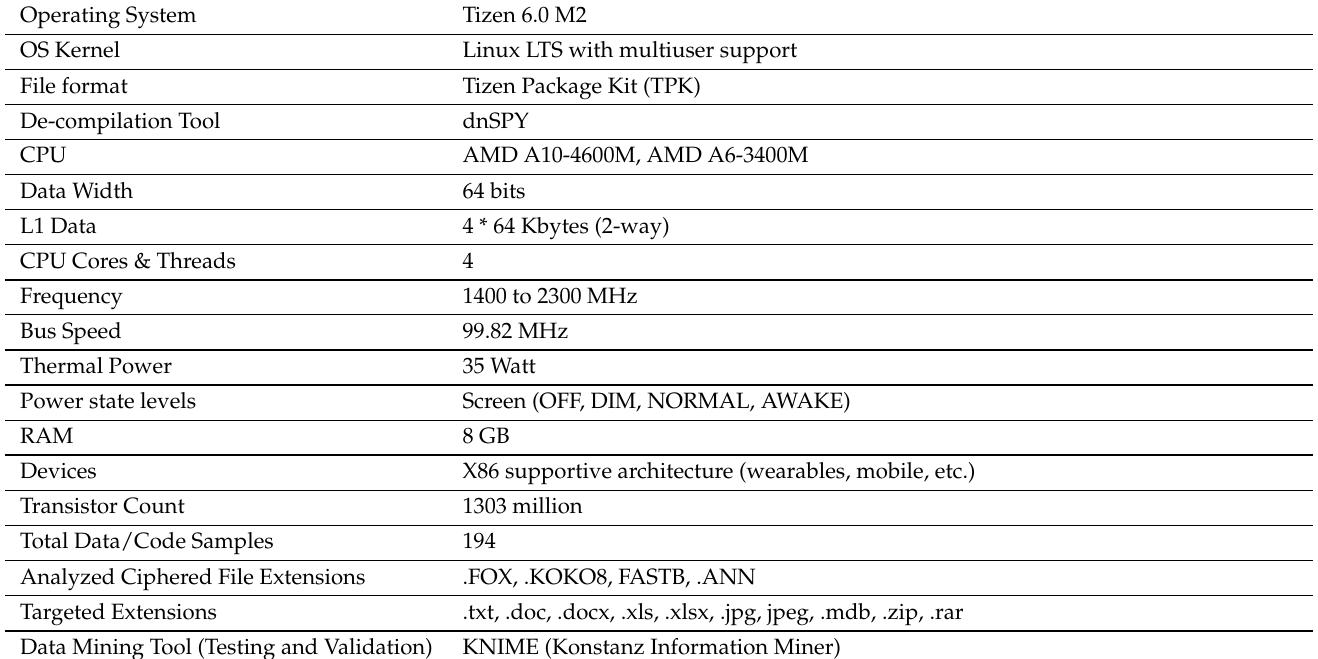
Table 5. Configuration for experimental